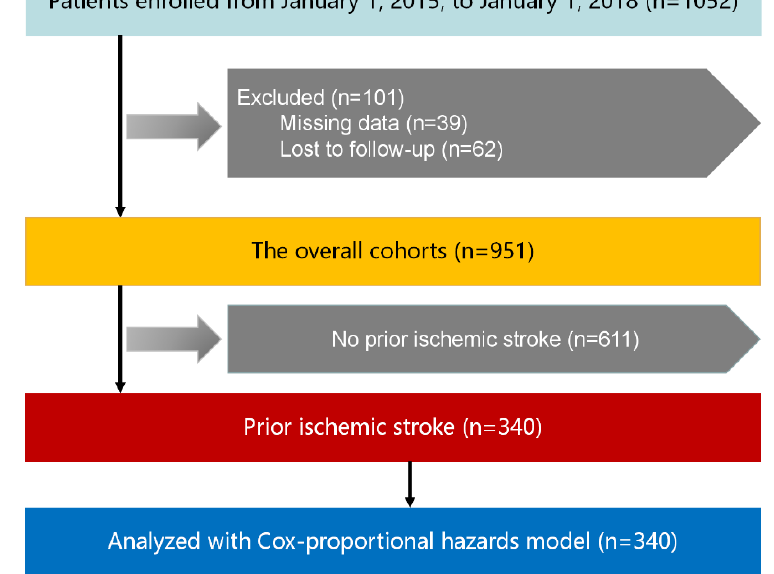
Figure 1. Selection process of patients.